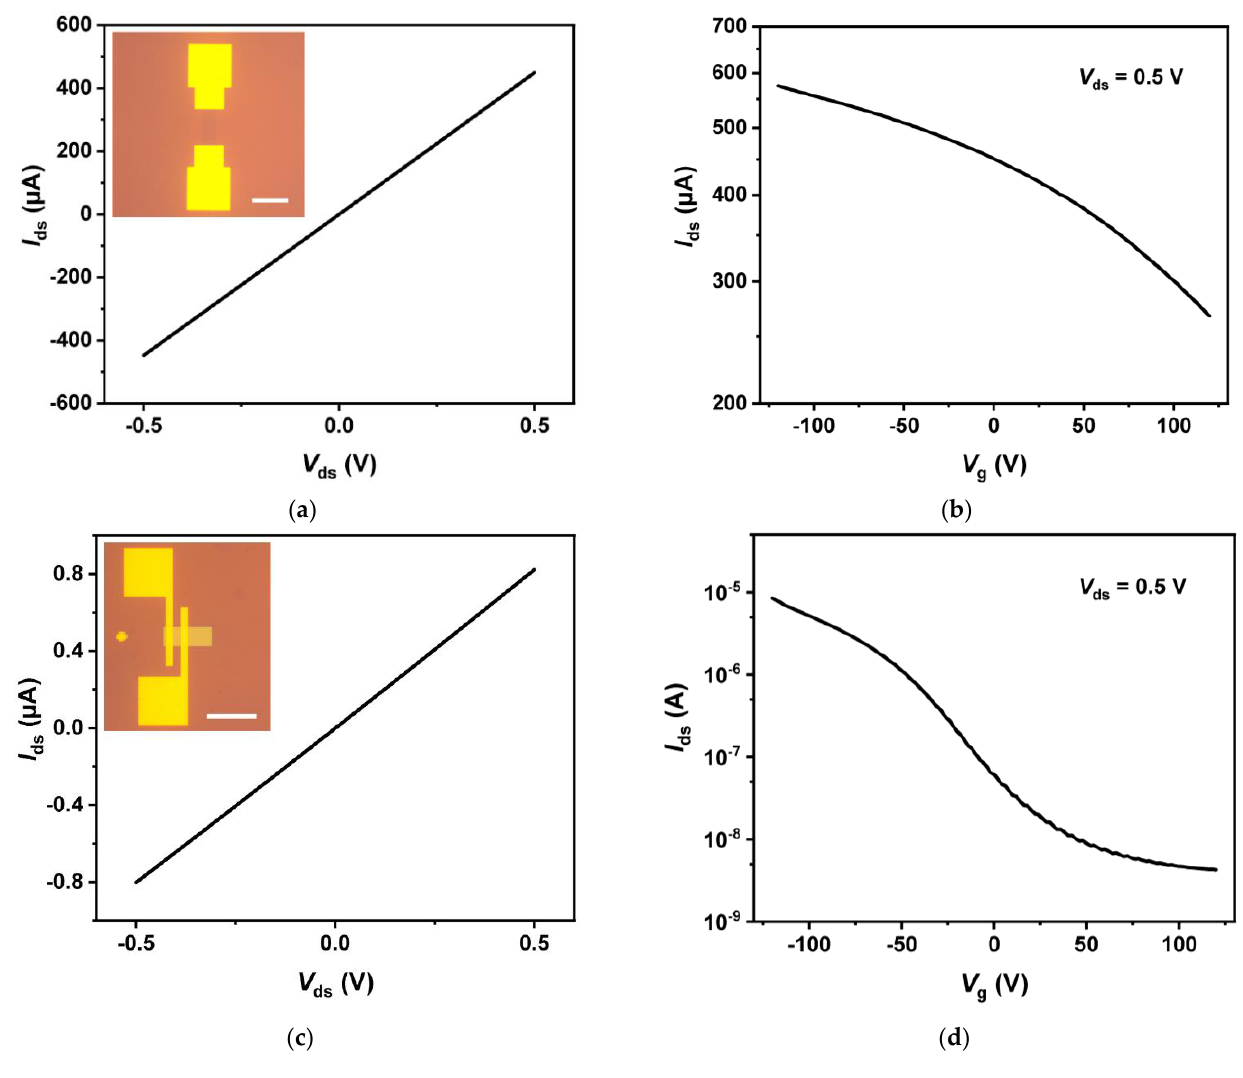
image of the MoTe 2 FET. The scale bar is 100 µ m. The I ds – V ds curve shows linear behavior, indicating indicating the ohmic contact between the MoTe 2 and the Pd/Au electrodes; ( d ) the transfer curve of